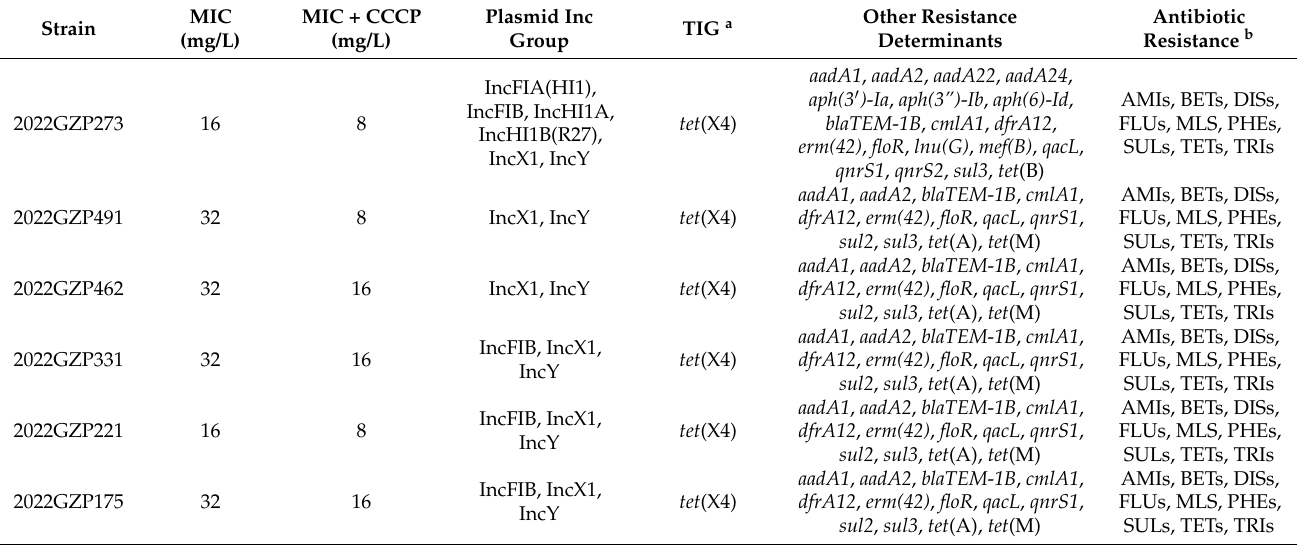
Table 1. The antibiotic susceptibility of tigecycline, effect of carbonyl cyanide 3-chlorophenylhydrazone (CCCP) on MIC values of tigecycline, and predicted plasmids of E. fergusonii